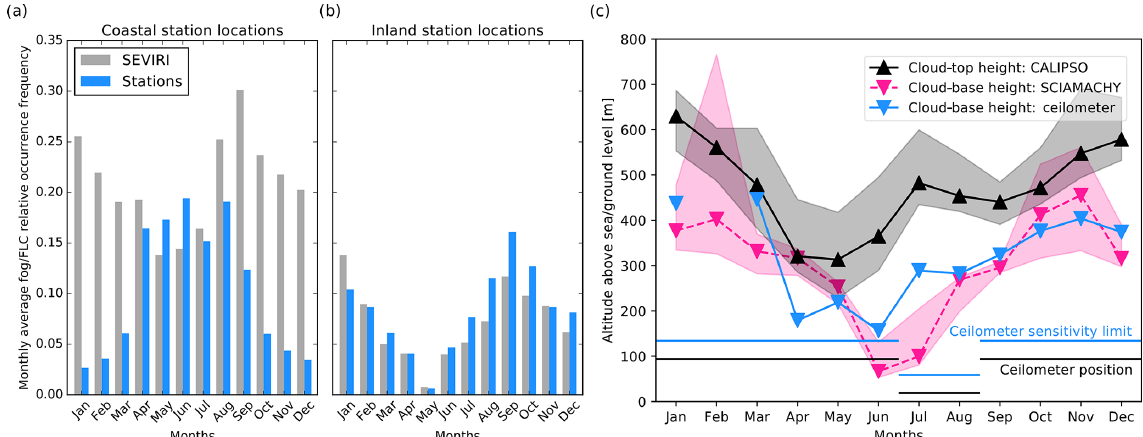
Figure 3. Monthly averaged relative fog/FLC occurrence frequency at locations of coastal (a) and inland stations (b) as defined in Fig. 1b. SEVIRI observations (2004–2017) are illustrated by grey bars; station measurements of ground fog (2015–2017) are in blue. (c) Medi- ans, 25th and 75th percentiles of monthly averaged CBH and CTH in the central Namib based on SCIAMACHY (above ground level; 22.5–24.0 ◦ S and 14.25–15.5 ◦ E; 2003–2009) and CALIPSO (above sea level; 22.5–24.0 ◦ S and 14.0–15.5 ◦ E; 2006–2017) observations, respectively. Ceilometer CBH observations (above sea level) are only available starting from September 2017. Ceilometer positions (Coastal Met from September to June and Swakopmund in July and August) and sensitivity limits are illustrated by thin horizontal lines and described in Sect.